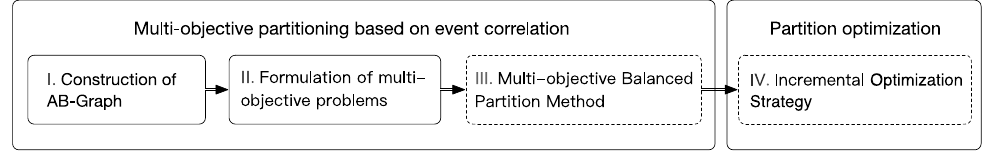
Figure 1. Workflow of the multi-objective partition method of marine sensor network based on degree of event correlation.